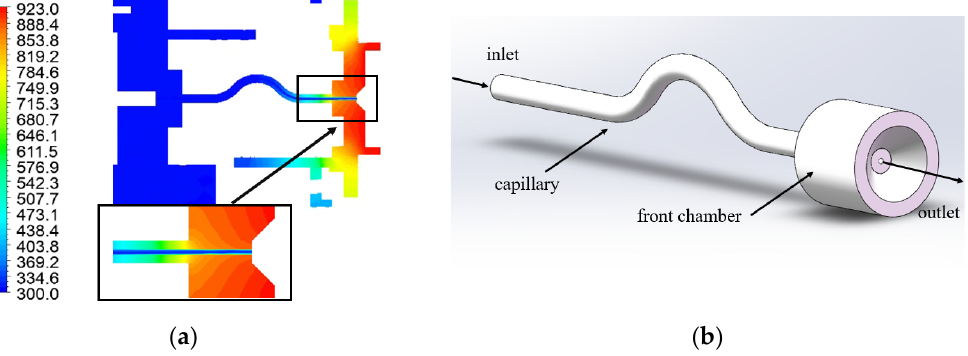
Figure 2. ( a ) ADN-based thruster temperature distributions of the axial plane at 0.25 s; ( b ) schematic diagram of the capillary.